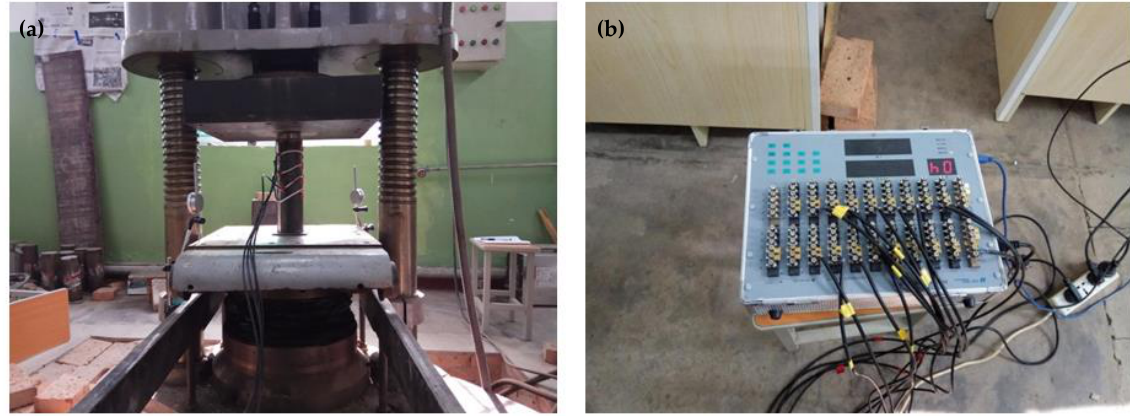
Figure 2. Test device model of CFST.